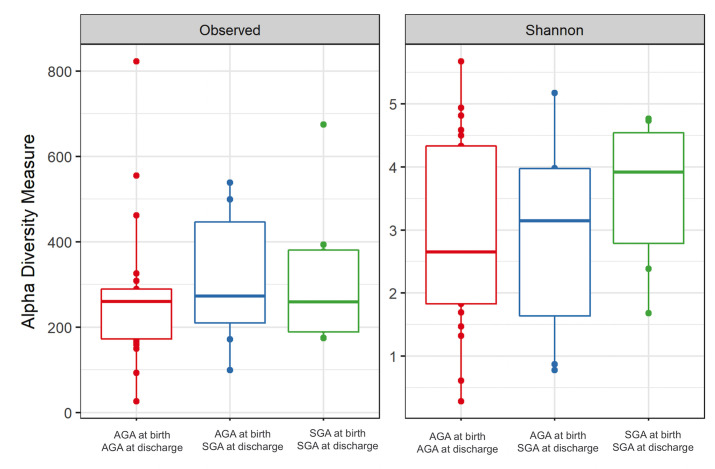
Alpha diversity measurements of meconium microbial communities from preterm infants comparing weight adequacy at birth and at discharge.The left panel presents the number of observed Operational Taxonomic Unities (OTUs) (p-value = 0.745). The right panel presents the Shannon microbial index of diversity (p-value = 0.127). Boxes span the first to third quartiles; the horizontal line inside the boxes represents the median. Whiskers extending vertically from the boxes indicate variability outside the upper and lower quartiles, and single circles indicate outliers. AGA: adequate for gestational age; SGA: small for gestational age. (The group SGA-LGA was excluded from data analysis, because of its limited size).